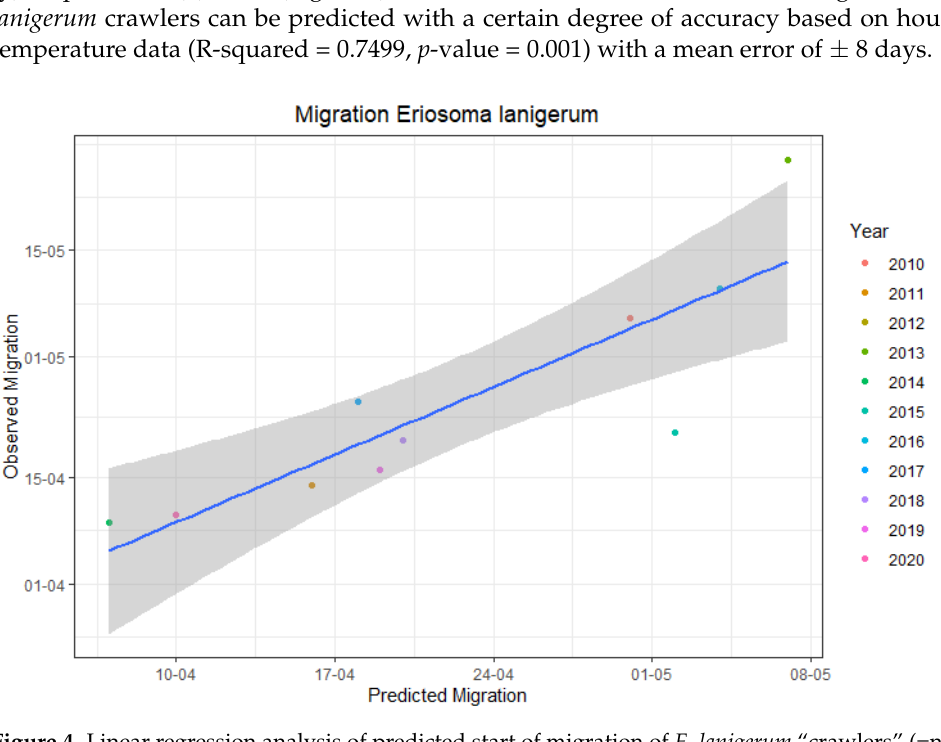
Figure 4. Linear regression analysis of predicted start of migration of E. lanigerum “crawlers” (=new first instar virginoparae) and observed dates of first migration activity in apple orchards monitored in this